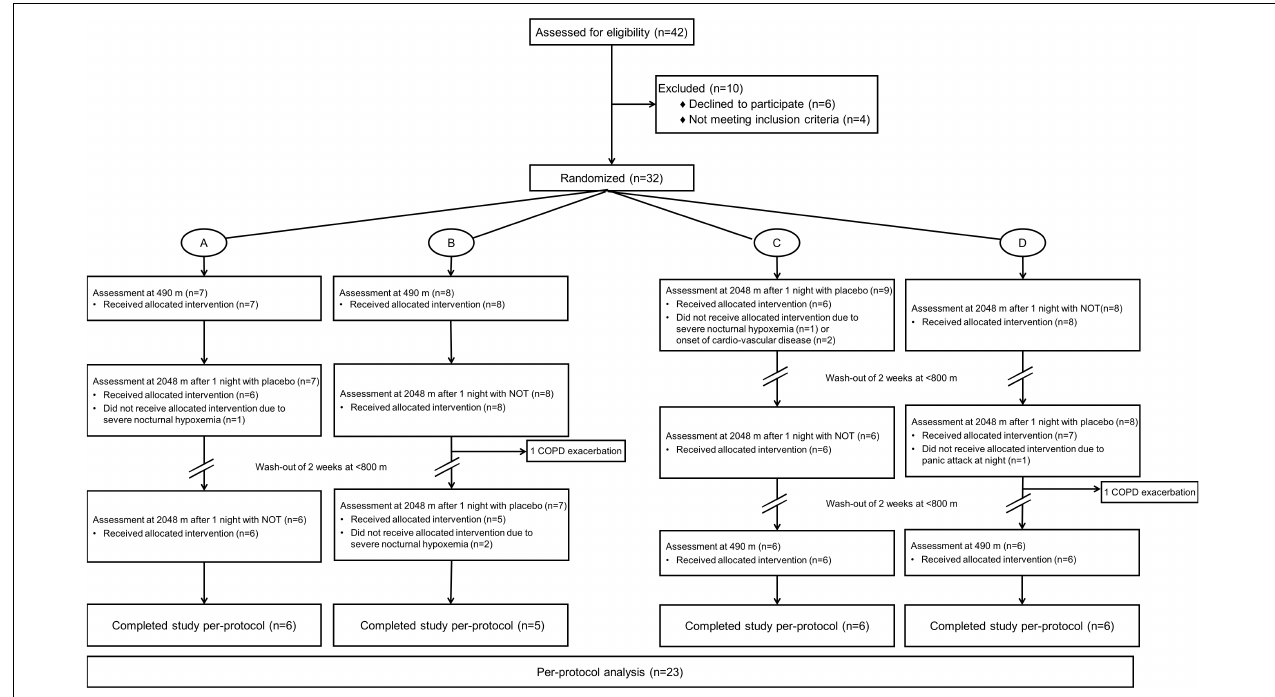
FIGURE 1 | Patient